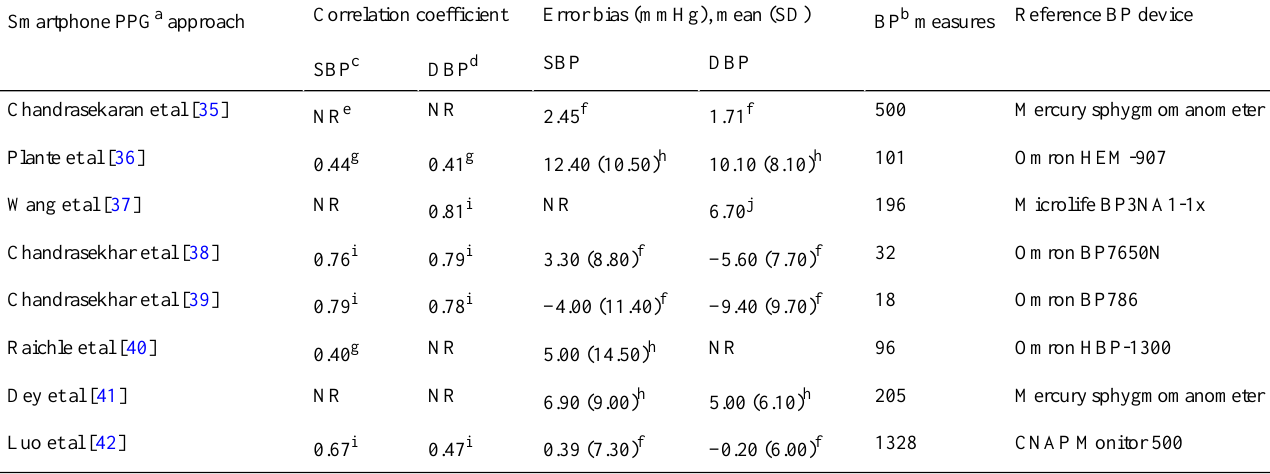
Table 1. Overview of smartphone-based blood pressure monitors using single or combined photoplethysmography